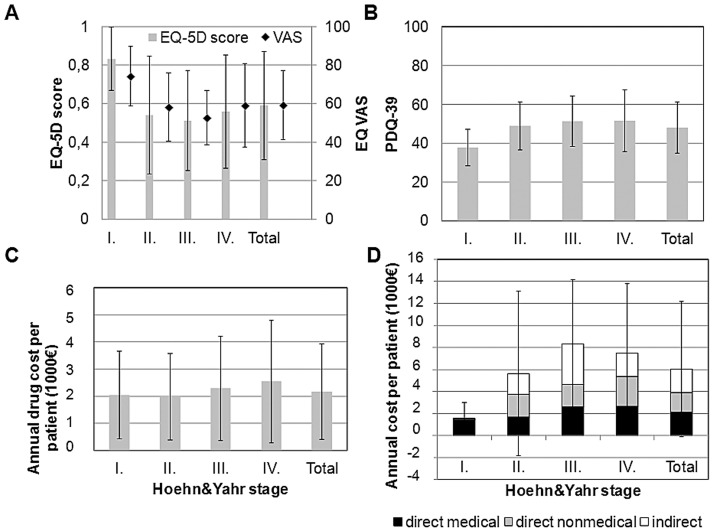
Quality of life, costs of medication, cost components in the Hoehn&Yahr categories.
A: EQ-5D and VAS scores B: PDQ-39 index scores C: Costs of medication therapy related to Parkinson's disease D: Distribution of cost components. Vertical lines indicate standard deviations.